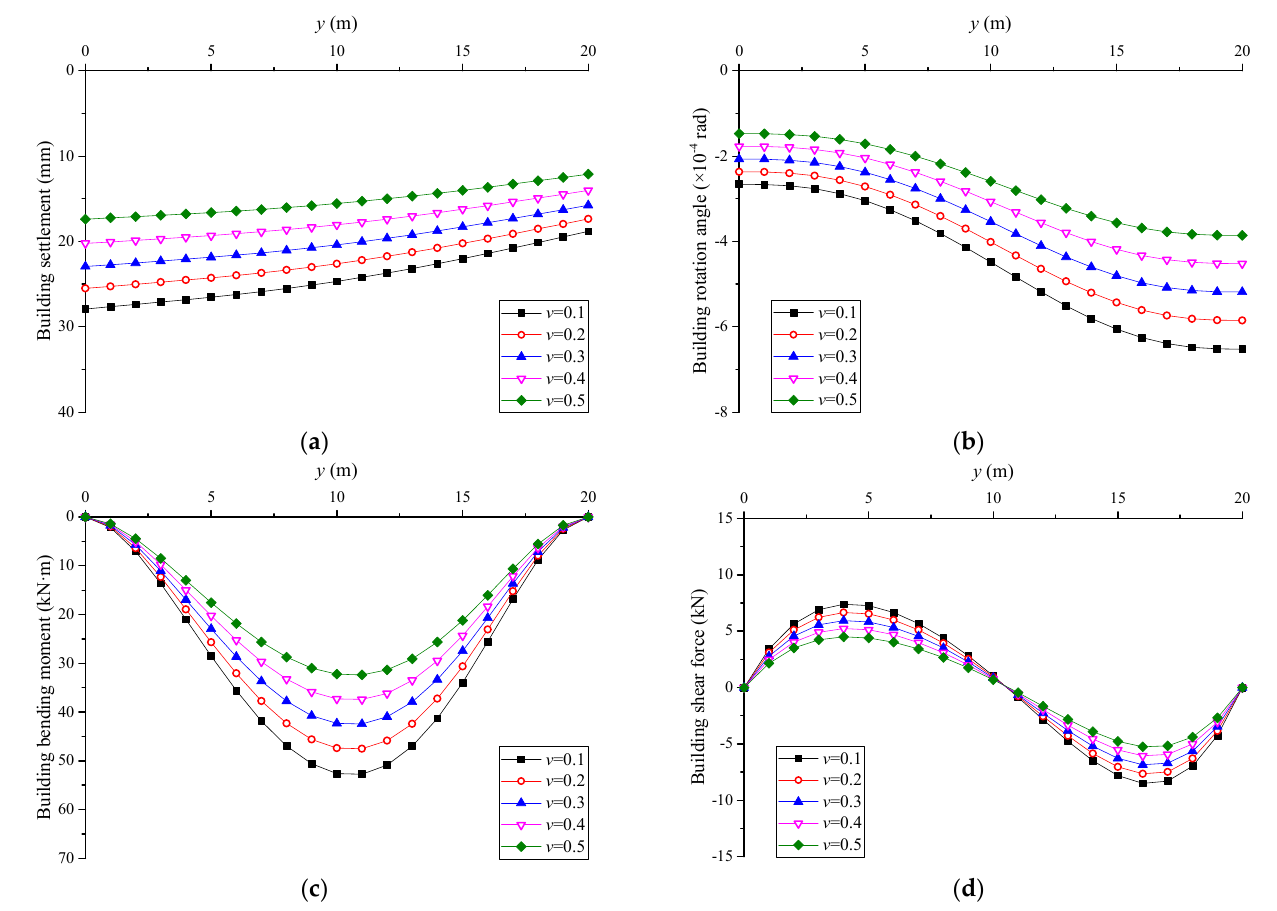
Figure 12. Building response with different soil Poisson’s ratios: ( a ) settlement; ( b ) rotation angle; ( c ) bending moment; ( d ) shear force.